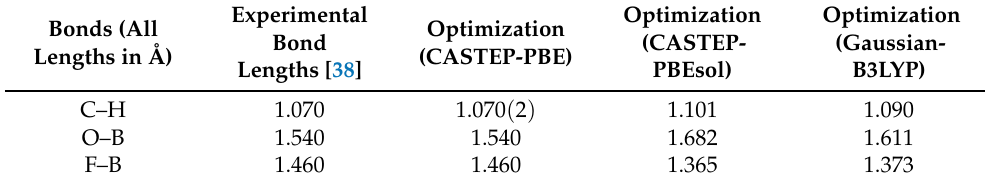
Table 5. Optimized bond lengths of the BF 3 OEt 2